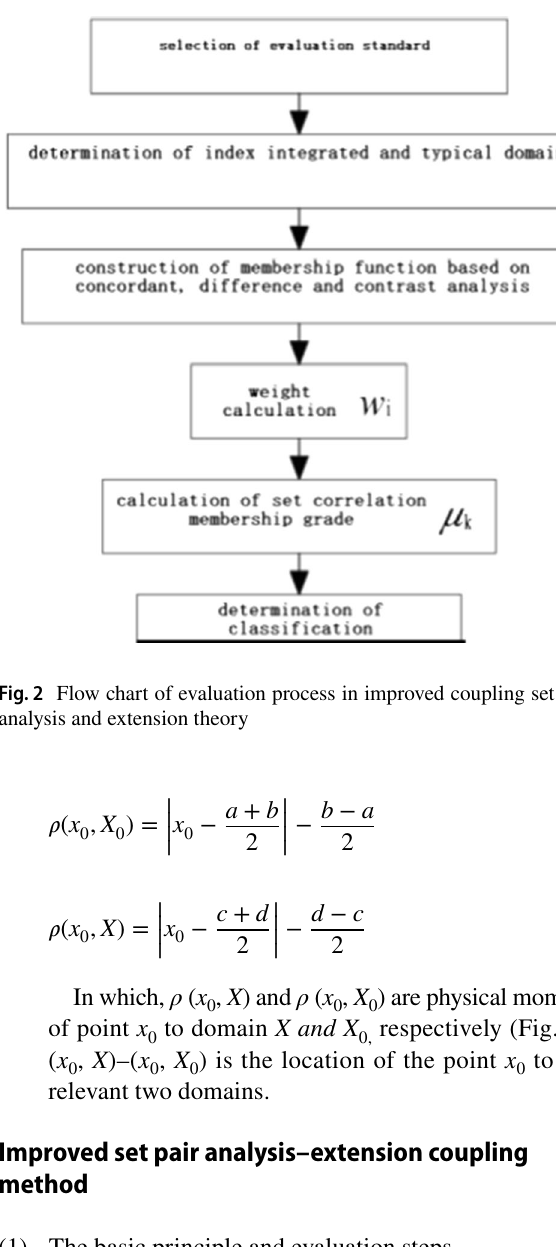
Fig. 1 Schematic diagram of extension set theory domain